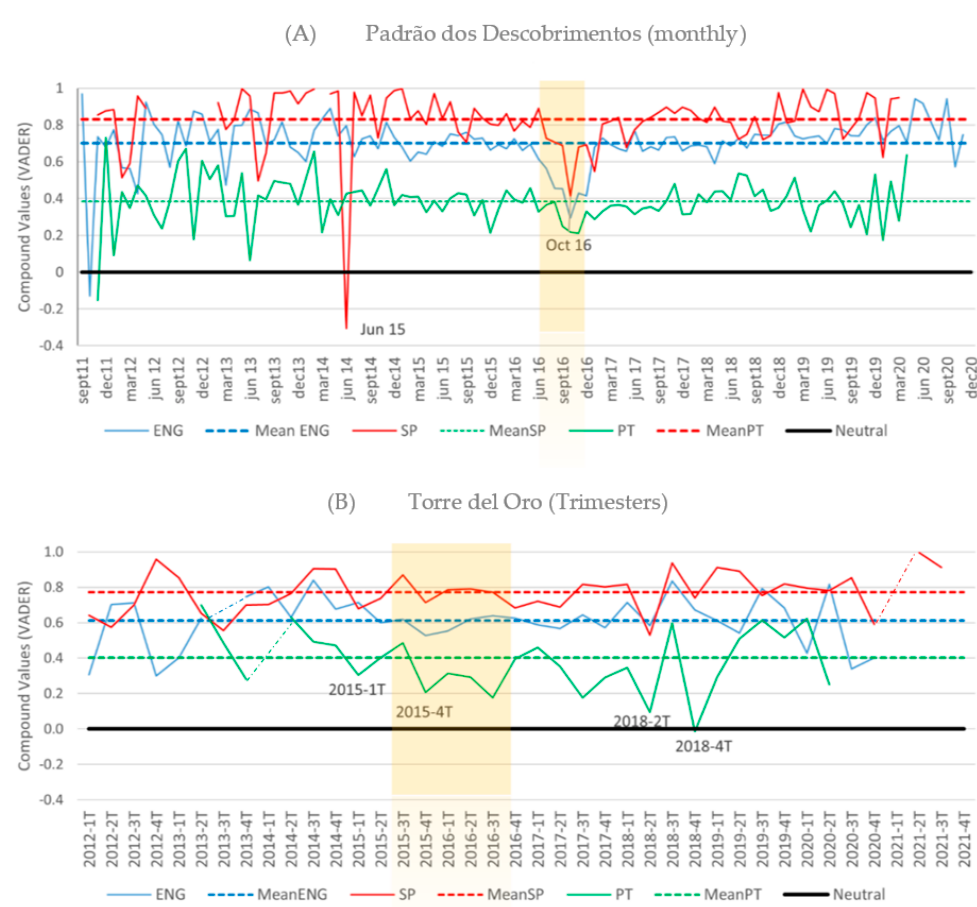
Figure 10. Compound results from VADER analysis from 2010 to 2020. Rectangular shadow repre- sents the period when there were interventions ( A ) on the façade and ( B ) on the promenade.